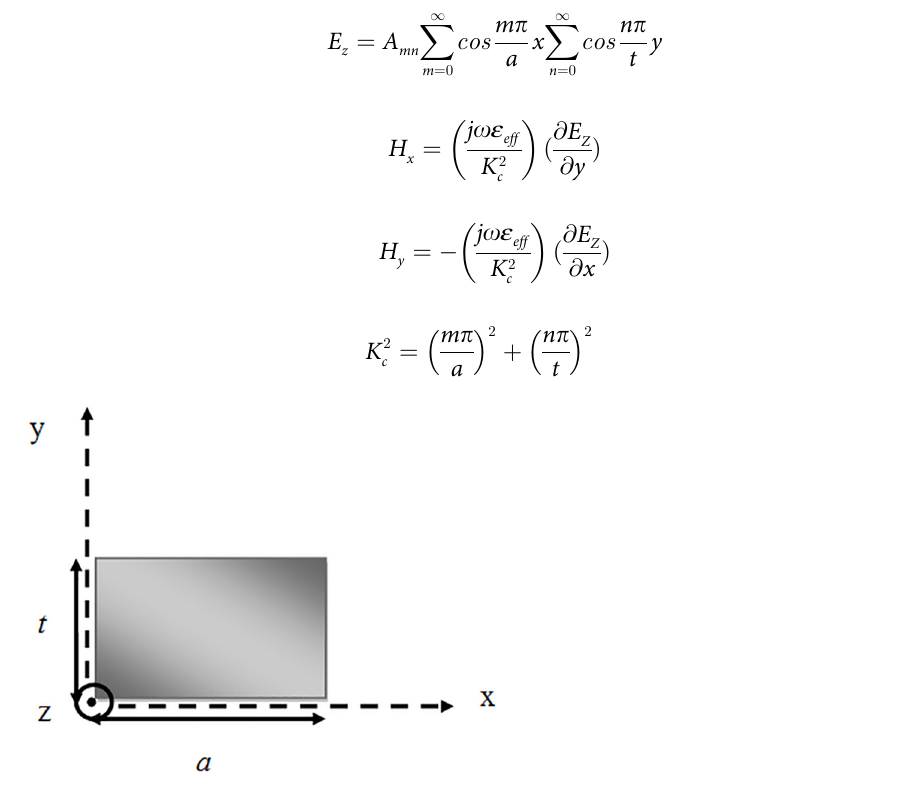
Fig 1. Top view of a generic rectangular